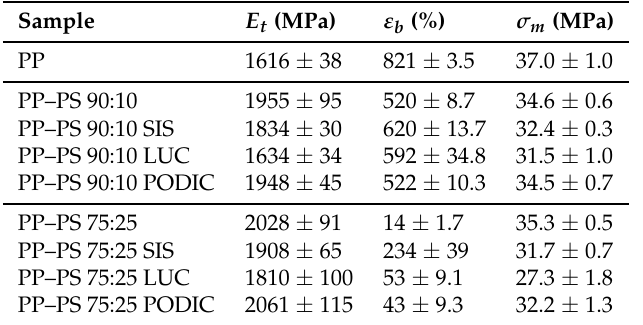
Table 4. Tensile modulus ( E t ), elongation at break ( ε b ) and tensile strength ( σ m ) of virgin PP and PP–PS blends obtained from tensile